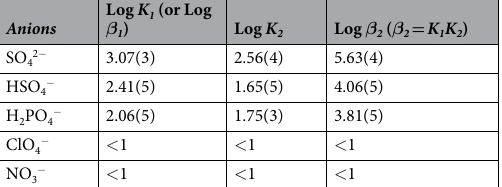
Table 1. Binding constants of L for anions (A) in DMSO- d 6a . a The binding constants were determined using a 1:2 binding model for the following reaction: +